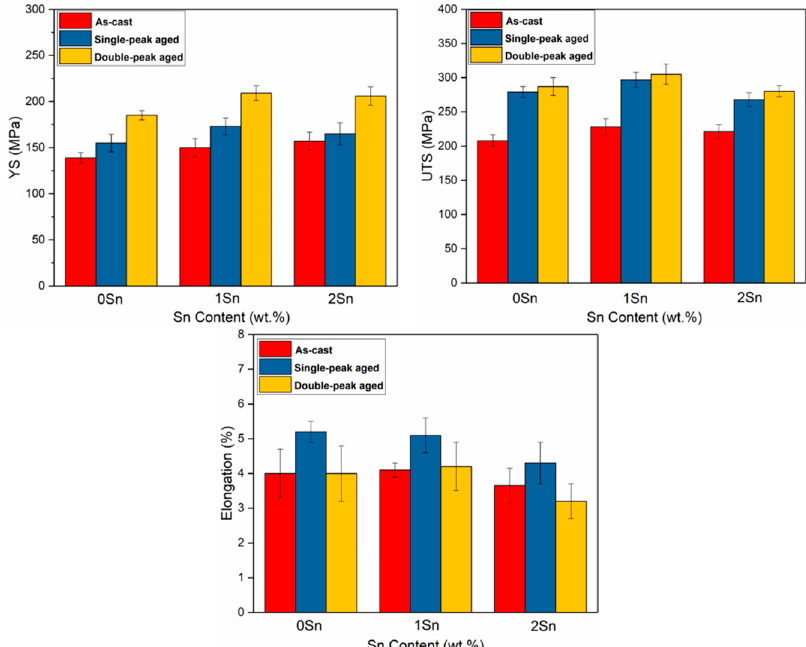
Figure 15. Mechanical properties of as-cast, single-peak aged and double-peak aged Mg-6Zn-4Al-xSn alloys. ( a ) Yield strength, ( b ) ultimate tensile strength, and ( c ) alloys. ( a ) Yield strength, ( b ) ultimate tensile strength, and ( c ) elongation.